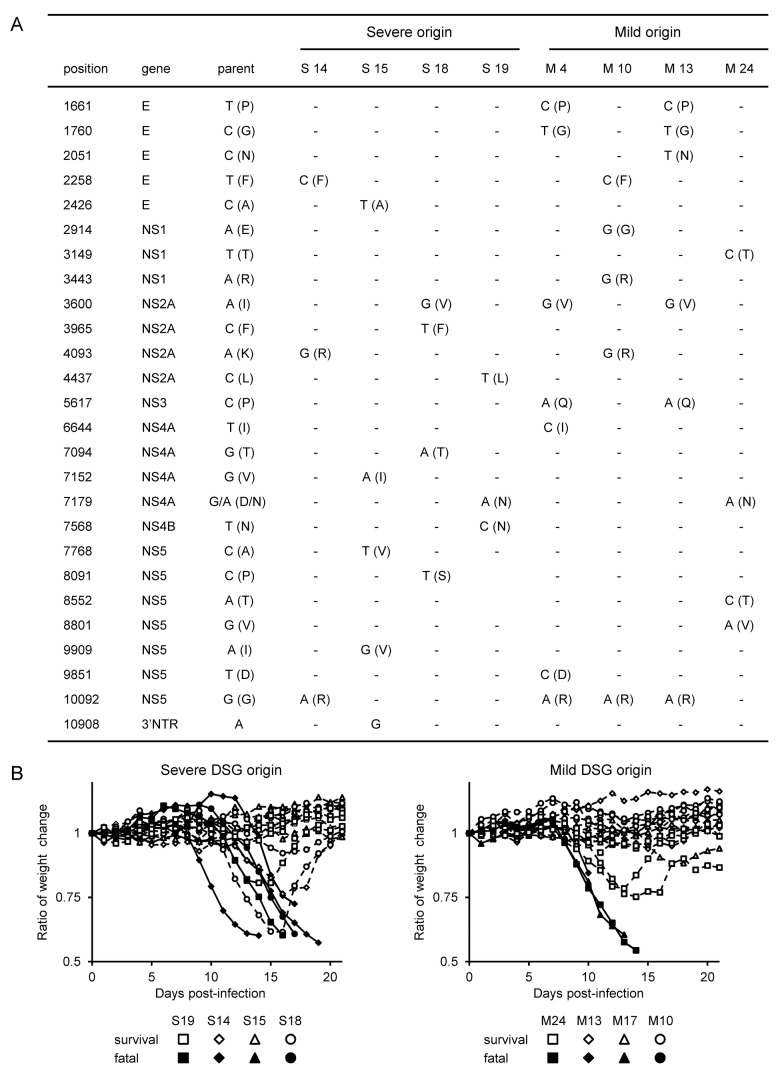
Viral sequences and their potential for fatal infection recovered from JaOArS982-infected mice.(A) Comparison of viral genome sequences (nucleotide and corresponding amino acid – in parentheses) between recovered viruses from brains of severe (S14, S15, S18 and S19) and mild (M4, M10, M13 and M24) cases of JaOArS982-infected B6 mice. (B) Weight changes of B6 mice infected with 104 pfu of recovered viruses from severe (S14, S15, S18 and S19) and mild (M17 replaced to M4, M10, M13 and M24) cases. Five mice in each group were inoculated subcutaneously and observed for 21 days. Closed and open symbols identify mice that died or survived, respectively, during observation period.